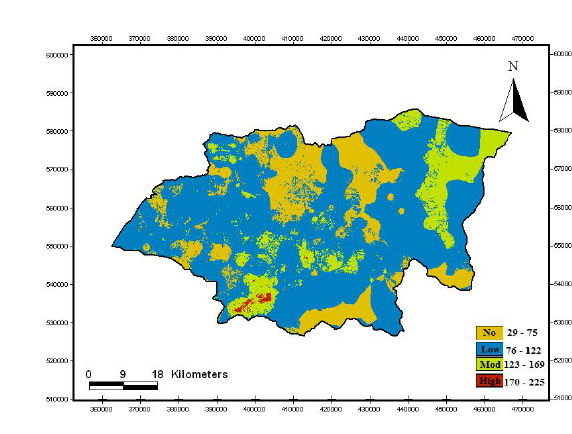
Figure 11. Generic DRASTIC vulnerability map classes of groundwater.